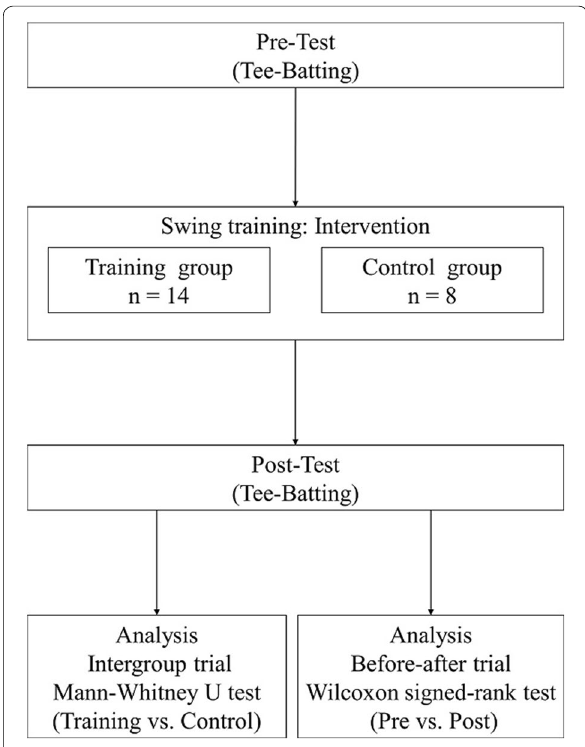
Fig. 4 Examination flow diagram Fig. 5 Variation in the extent of change (pre-test and post-test difference) in swing speed (km/h). *p values were derived using the Mann–Whitney U test (*p <